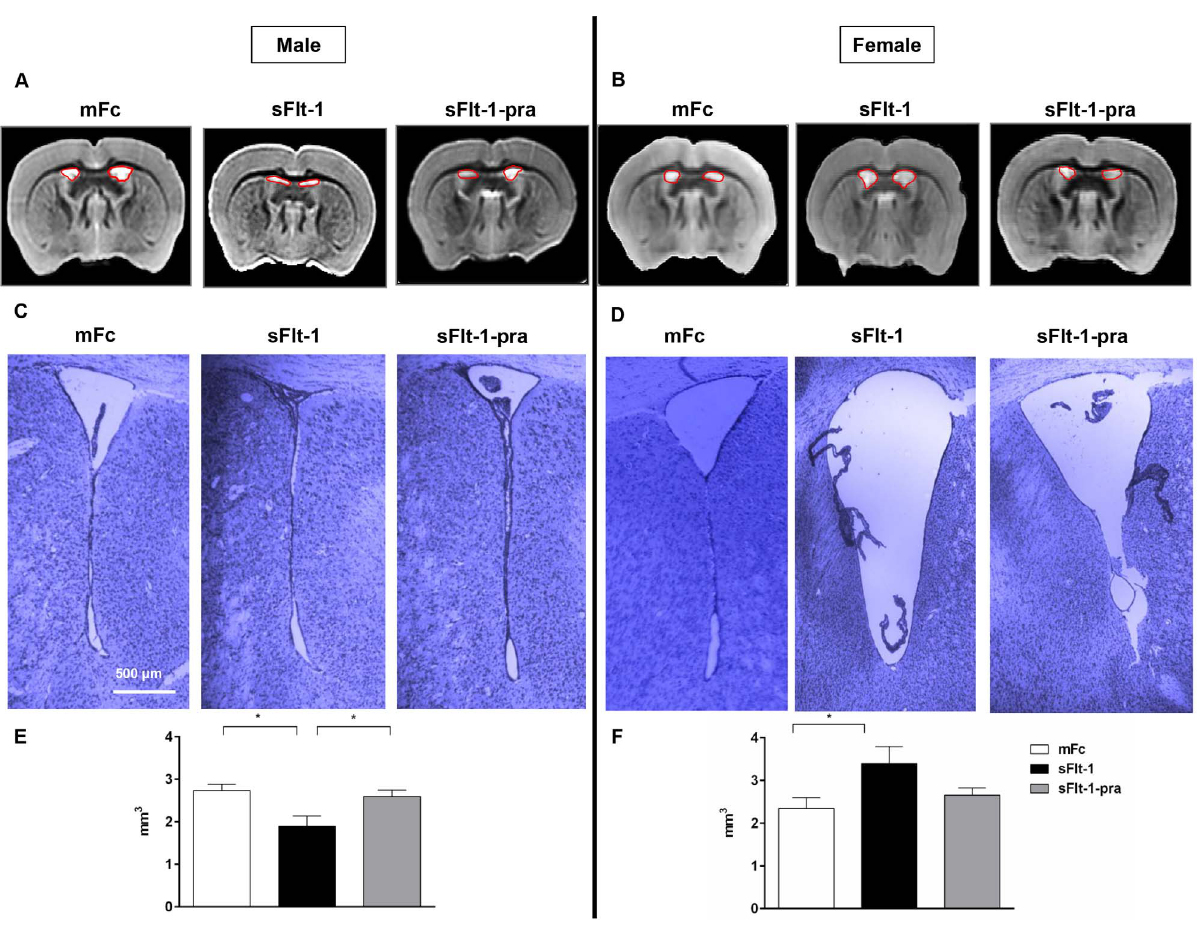
Figure 3. Magnetic Resonance Images of 6 Month Old Offspring Brains. Three-dimensional T2-weighted images of whole brain were obtained using a vertical bore 11.7 Tesla MRI scanner. Here in these representative coronal slices, the ventricles and periventricular tissue of male (A) and female (B) offspring are outlined in coronal view, allowing comparison between treatment groups. A decrease in ventricular volume was seen in male sFlt-1 offspring (A: sFlt-1) when compared to controls (A: mFc). Pravastatin exposure (A: sFlt-1-pra) reversed this effect. An opposite trend was seen in the female sFlt-1 offspring brain (B: sFlt-1) when compared to control (B: mFc) and pravastatin-treatment offspring (B: sFlt-1-pra). Nissl staining of coronal sections at a single ventricle and its periventricular tissue in adult offspring brains at 40 X magnification is shown in panels C and D. In these representative images, male offspring showed a decrease in volume in sFlt-1 (C: sFlt-1) offspring when compared to control (C: mFc). In-utero pravastatin exposed male offspring (C: sFlt-1-pra) showed normalization of ventricular shape and size. An increase in ventricular volume is seen in female sFlt-1 offspring brains (D: sFlt-1) when compared to control (D: mFc). Though complete resolution is not seen, there is improvement in ventricle size in the pravastatin-exposed female offspring (D: sFlt-1-pra). These representative images correlate with MRI volumetric data for male (E: mFc (n=9), sFlt-1 (n=3), sFlt-1-pra (n=6)) and female (F: mFc (n=6), sFlt-1 (n=3), sFlt-1-pra (n=10)) offspring brains as analyzed by 1-way ANOVA. The male sFlt-1 offspring had significantly decreased volume when compared to mFc controls and the pravastatin treatment group in males (E: p=0.02), whereas the opposite effect was seen in female offspring (F: p , 0.05).